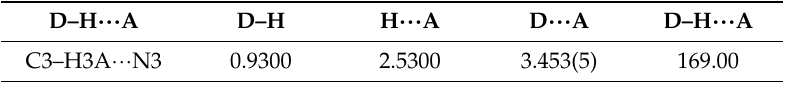
Table 2. Hydrogen-bond geometry (Å, °).